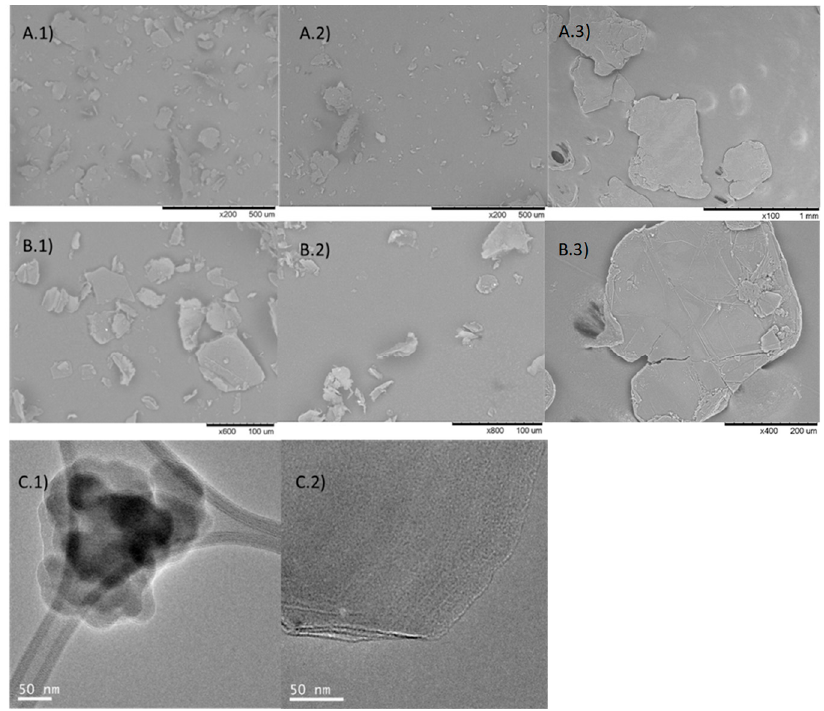
Figure 3. (A,B ) SEM images. 1) Sgraphene-1 , 2) Sgrapehene-2 , 3) graphite flakes. ( C ) TEM images. 1) Sgraphene-1 , 2) Sgrapehene-2 .